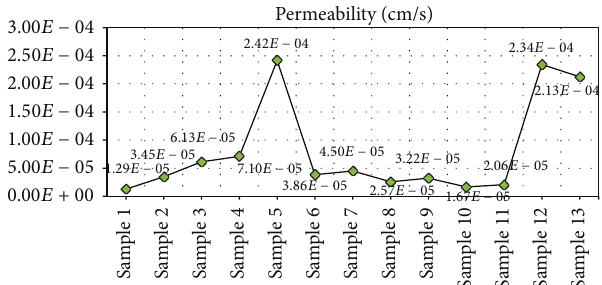
Figure 8: Distribution of permeability for different samples.